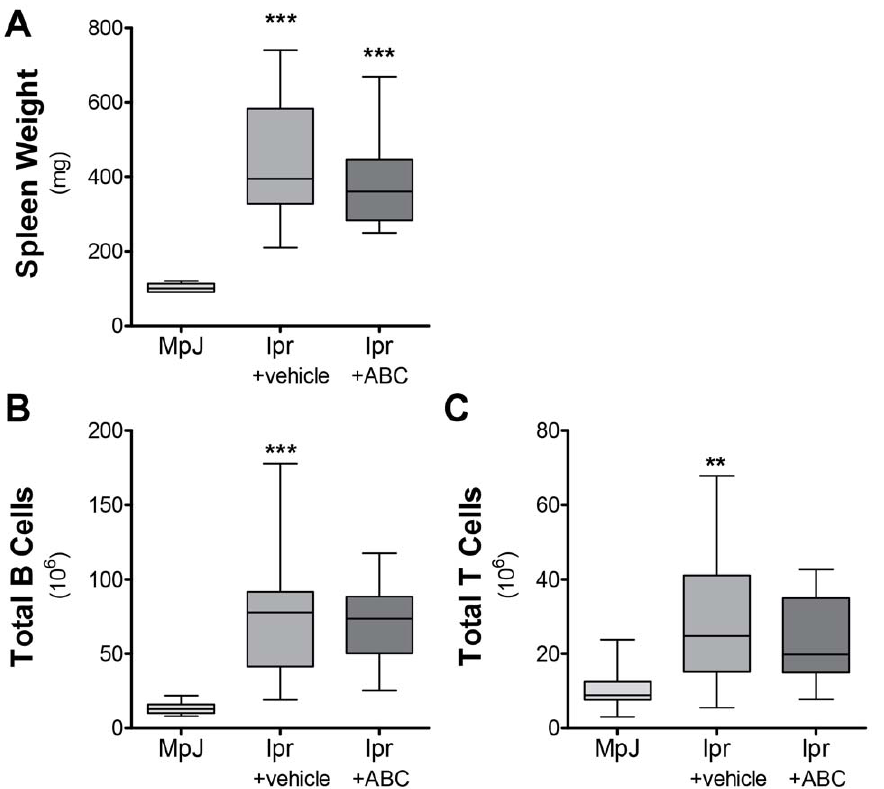
Figure 4. Spleen weight and lymphocyte counts are not significantly altered by ABC294640. MRL/MpJ mice were treated with vehicle and MLR/lpr mice were treated with vehicle or ABC294640 for 10 weeks. A ) Spleen weight was measured following euthanasia from mice at 20 weeks of age. B ) Total B and C ) T cell populations were analyzed using FACs flow cytometry. Data represent mean 6 SEM, n $ 10; **p , 0.01, ***p , 0.001 treated vs.